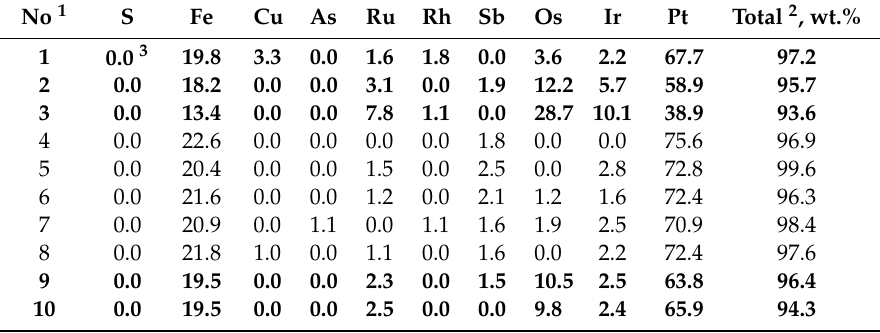
Figure 3. BSE image showing multiphase Grain No. 2. ( a ) A placer grain of Pt 3 (Fe,Cu) consists of a rim of Cu-enriched alloy phase (hongshiite PtCu) with inclusions of rhodarsenide (Rh,Pd) 2 As. ( b , c ) The exsolution micro-lamellae of rutheniridosmine (the decomposition of a solid solution) in isoferroplatinum and platarsite (PtAsS). For the composition of measurement points see Table 5. White—isoferroplatinum (Pt 3 Fe) and osmium (Os); light gray and gray—platarsite (PtAsS), cooperite (PtS), and sperrylite (PtAs); rectangular contours—the position of the microsites “b” and “c”. Table 5. The composition of isoferroplatinum (1–10) and platarsite (11–22) of grain No. 2, “clean” and with inclusions of Ru-Os-Ir lamellae, according to SEM-EDS analysis,